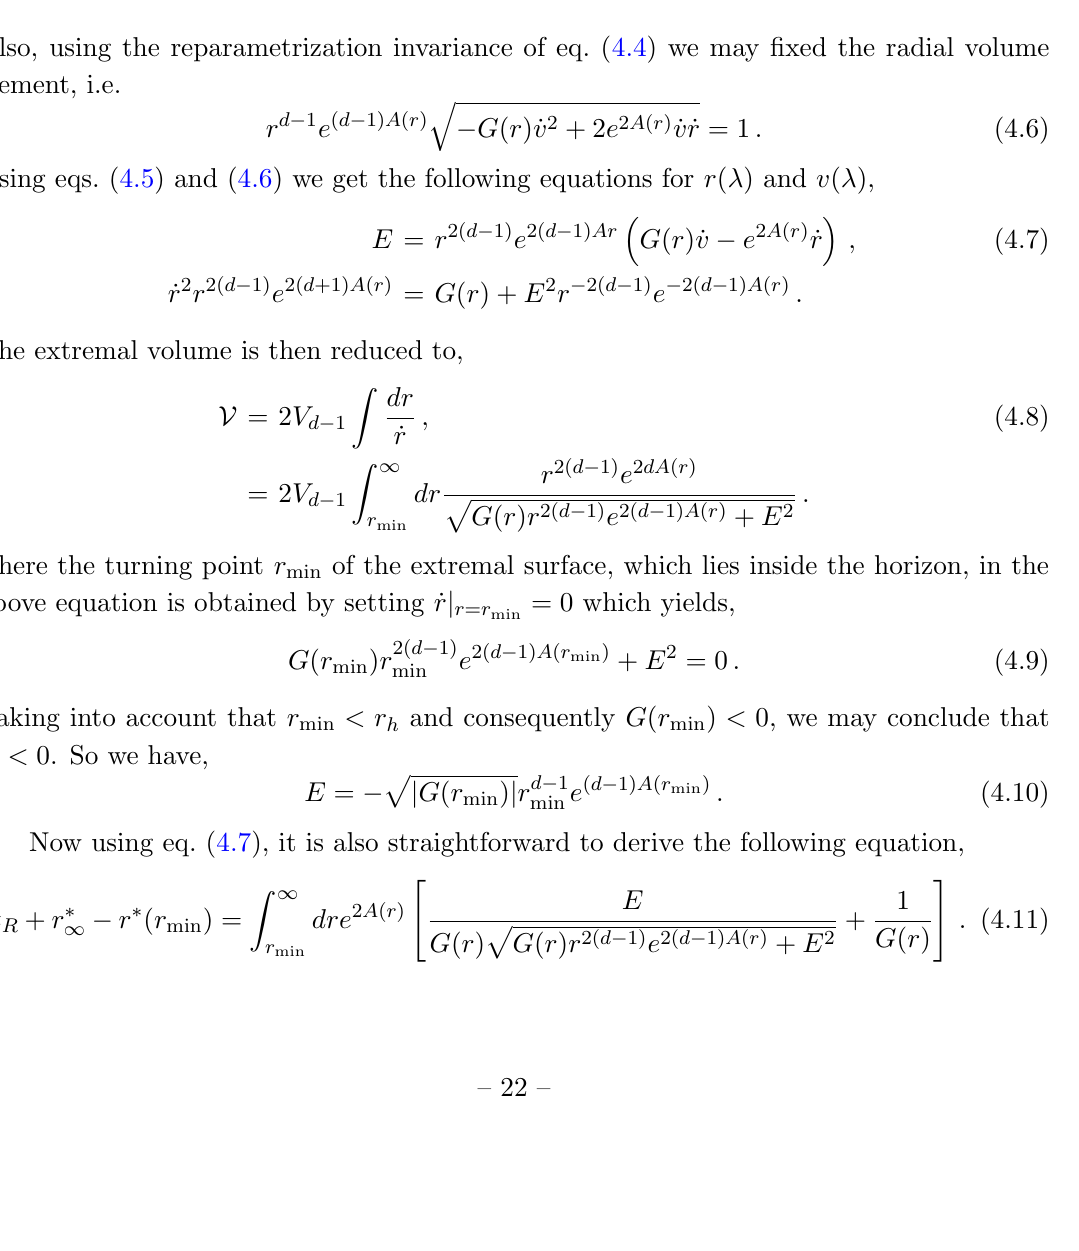
Figure 6 . Representation of maximal volume surface connecting the two sides of the eternal AdS black hole. The CV conjecture implies that the complexity is proportional to the maximal